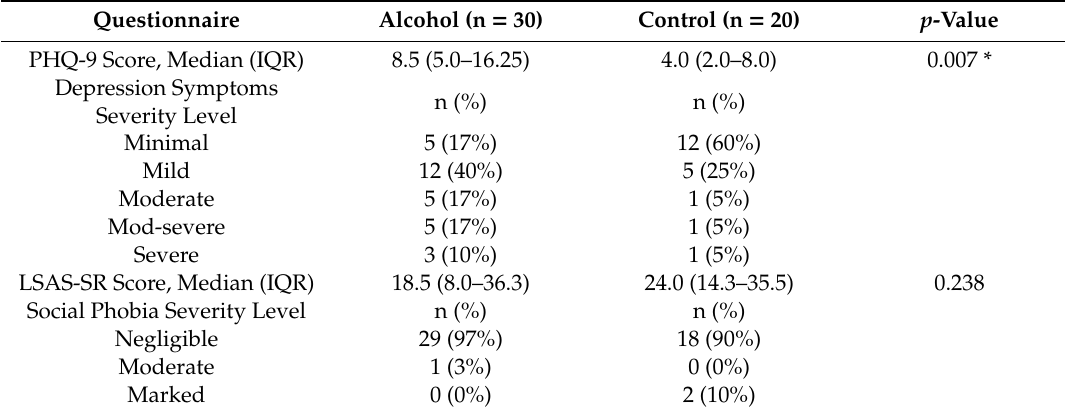
Table 2. Scores and severity in participant’s depression and social anxiety.